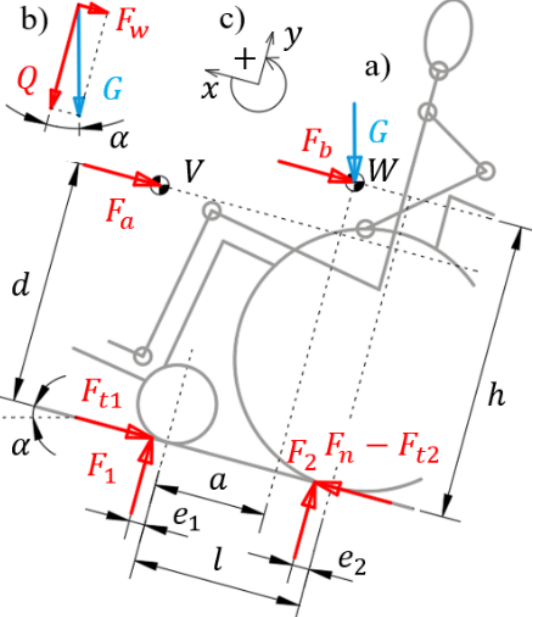
Figure 2. The distribution of forces acting on the wheelchair along with the user; ( a ) side view of the system, ( b ) projection of weight components, ( c ) positive directions of the adopted coordinate system, point W —the centre of gravity of the system, point V —the centre of height of the system; based on [44].